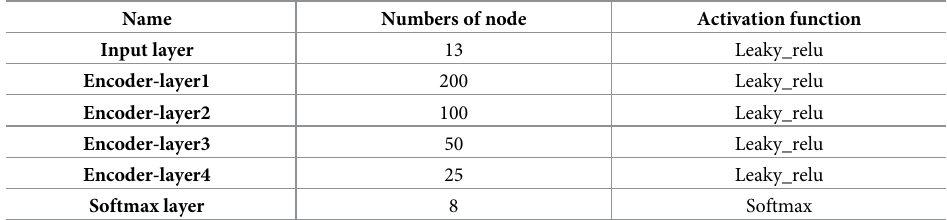
Table 5. GAN-SAE network settings at each